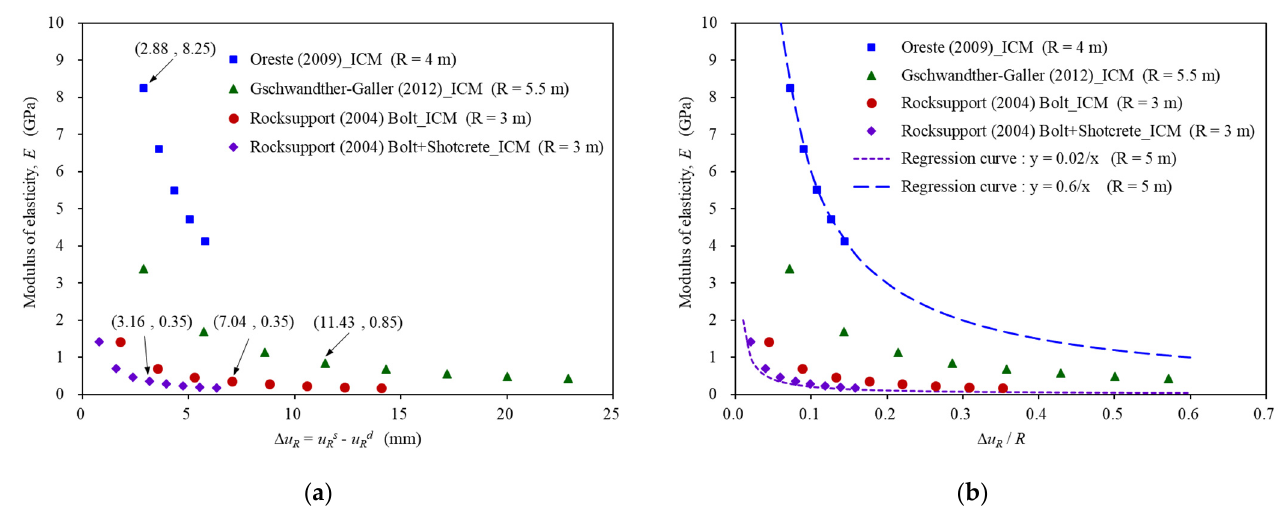
Figure 5. Estimation of the modulus of rock mass ( E m ) from the difference of the radial displacement between point C and point E in the analysis (ICM). ( a ) The comparison with the original data, and ( b ) the description of the regression curve.